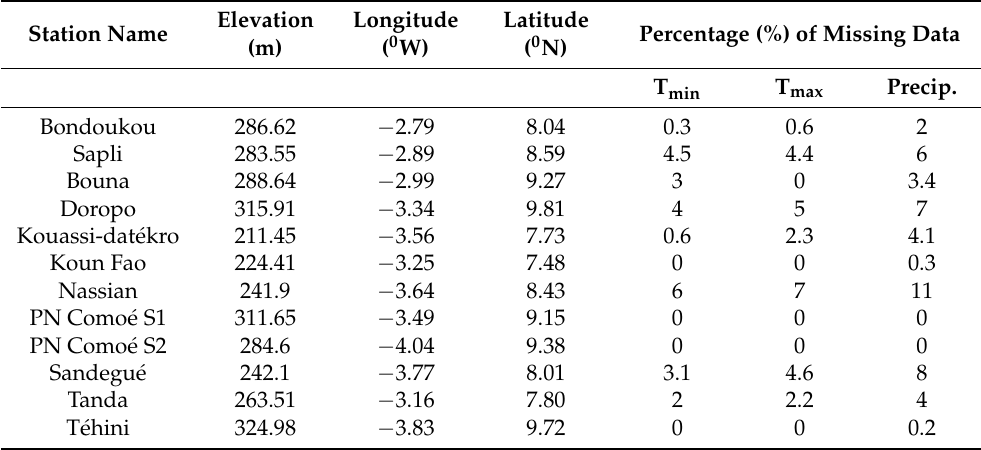
Table 1. Geolocation of the stations with the percentage of missing data.